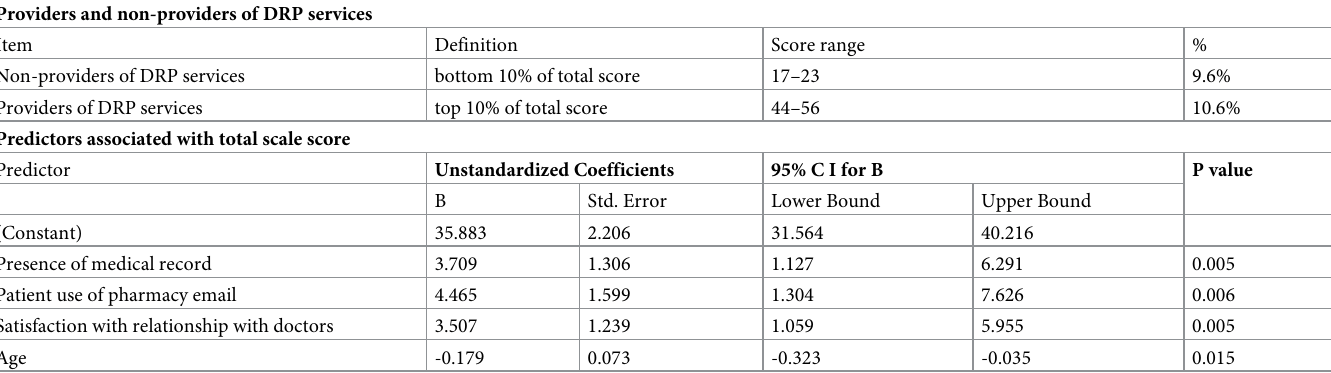
Table 4. Providers and non-providers of DRP services and predictors associated with total scale score among community pharmacists (N =